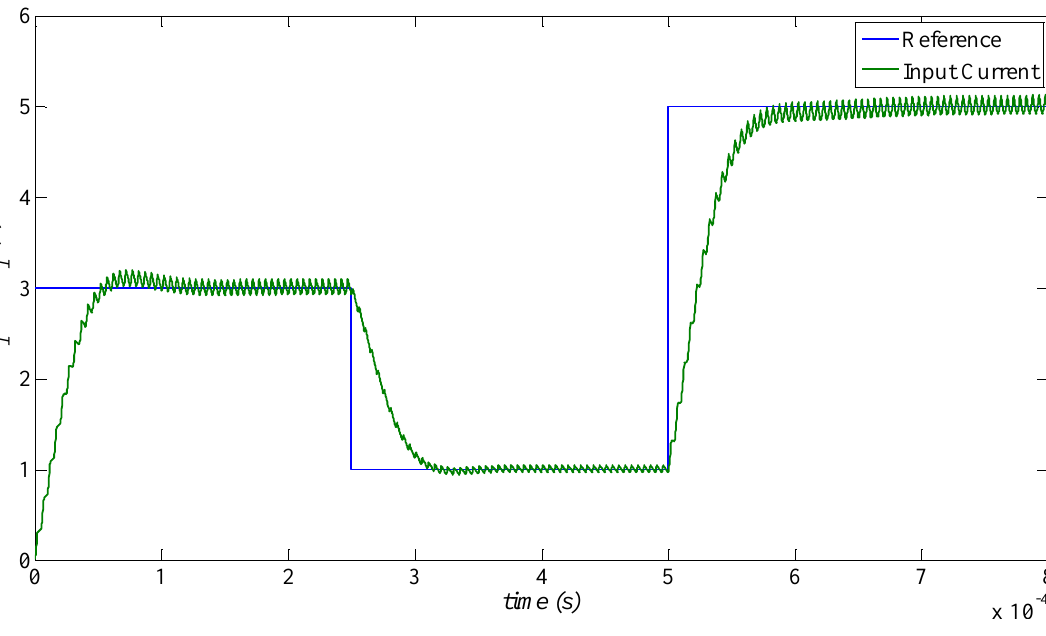
Figure 10. Step response of the proposed SMC.